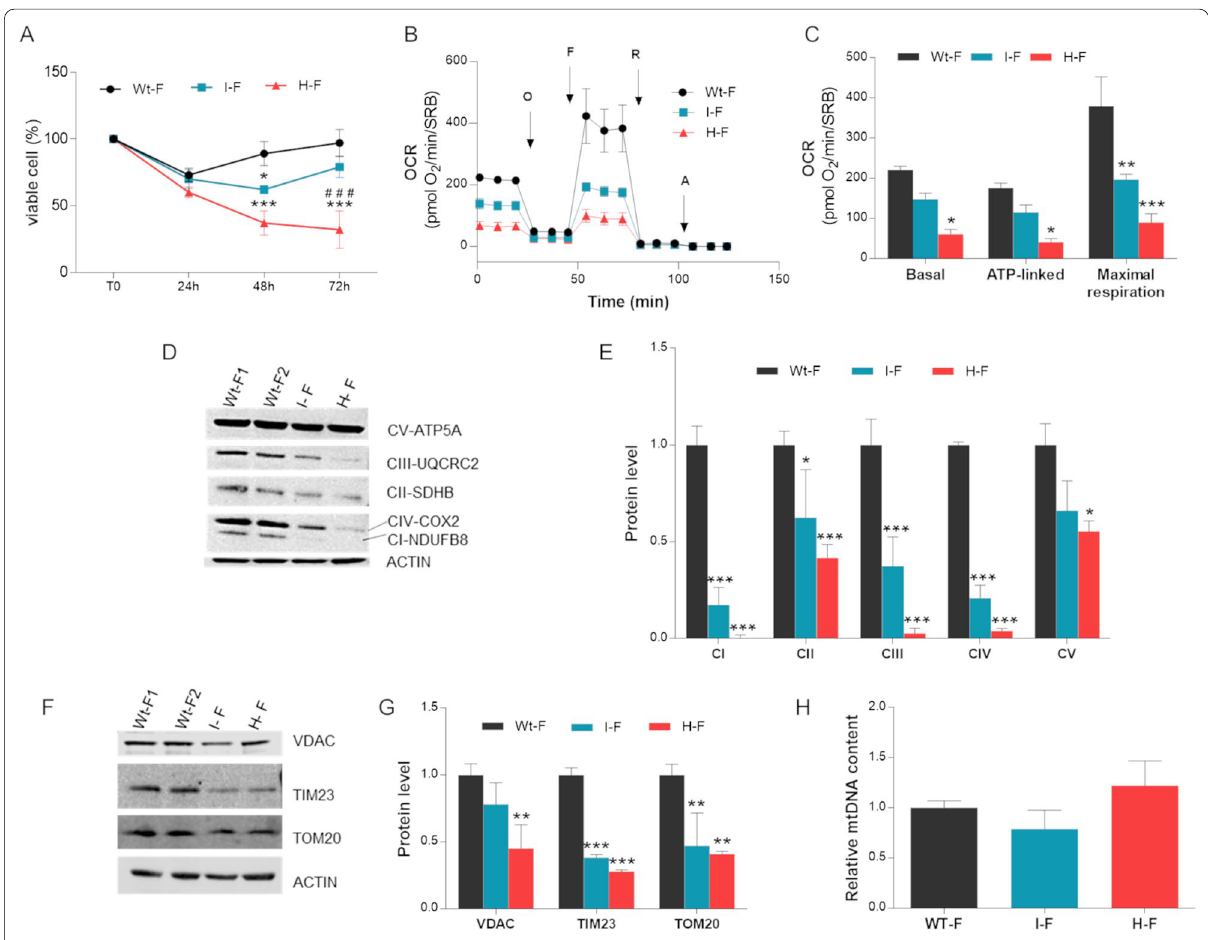
Fig. 2 Bioenergetics assessment in MERRF fibroblasts. A Cell viability was evaluated growing cells for 24 h, 48 h and 72 h in galactose-medium and by performing SRB assay. Data are means SEM of three independent experiments (biological replicates). B OCR expressed as pmoles O 2 /min, ± normalized for protein content, under basal conditions and after injection of oligomycin (O), carbonyl cianide 4-(trifluoromethoxy) phenylhydrazone (FCCP; F), rotenone (R) and antimycin A (AA). Data are means SEM of three independent experiments (biological replicates). C Basal, ATP-linked ± and maximal respiration. All values are means SEM of three independent experiments (biological replicates). D Western blot of OXPHOS + subunits; ACTIN was used as loading control. One representative experiment out of three is shown. E Densitometry of OXPHOS subunits of three independent experiments (biological replicates). All data are means and SEM and are normalized to control cells. F Western blot of VDAC, TIM23 and TOM20; ACTIN was used as loading control. A representative blot of three independent experiments is shown for each protein. G Densitometry of VDAC, TIM23 and TOM20 content. All data are means and SEM and are normalized to control cells. H mtDNA content evaluation by qPCR. All values are expressed as means and SEM of four biological replicates and are normalized to control cells. Statistical analyses were performed with ANOVA test (Tukey’s multiple comparisons test). *, ** and *** values significantly different from the control cells, p < 0.05, p < 0.01, p < 0.001 respectively; # , ## and ### values significantly different from the I-mutant, p < 0.05, p < 0.01, p < 0.001, respectively. Wt-F wild type fibroblasts, I-F